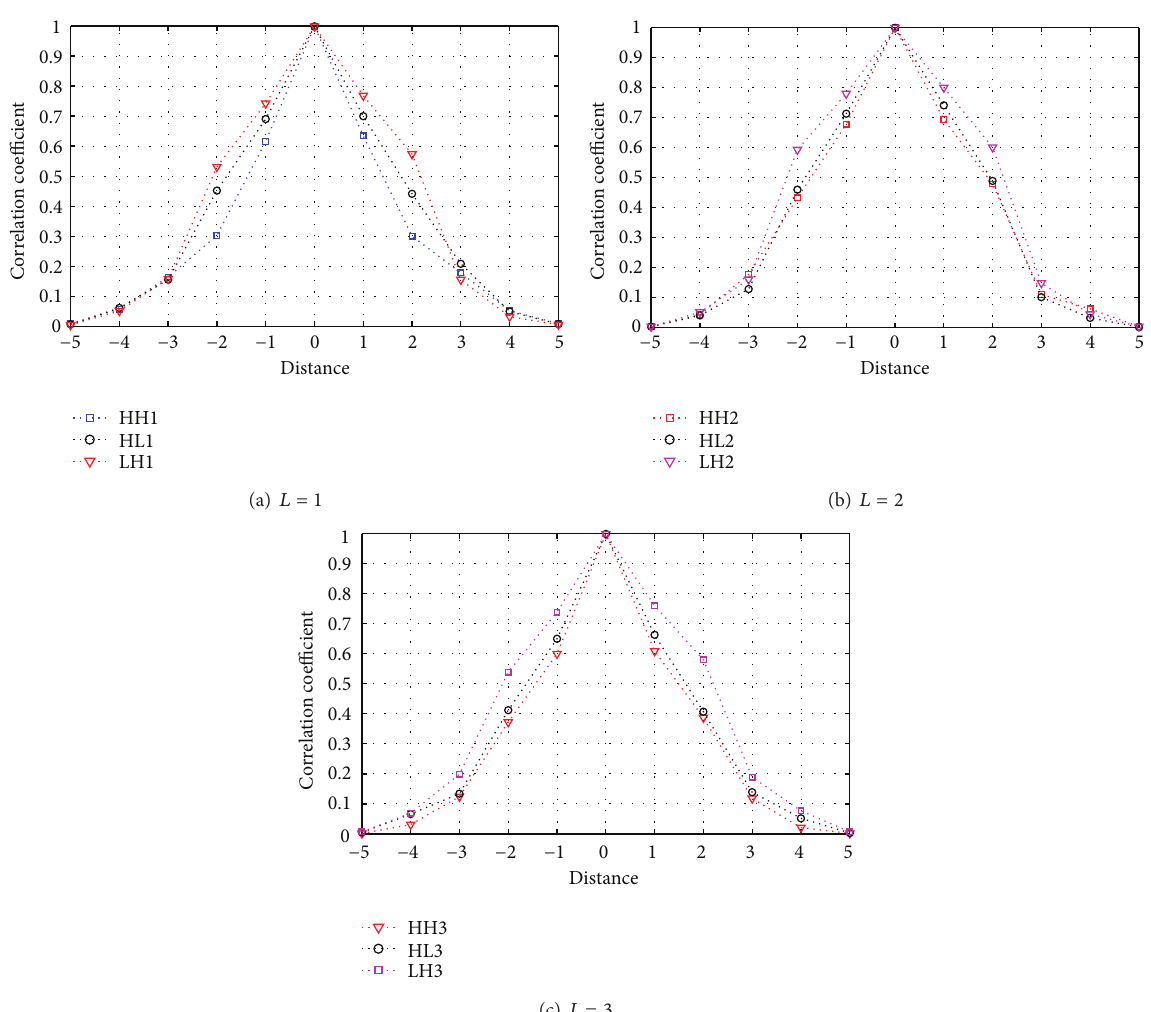
Figure 5: The correlation between wavelet coefficients in a small